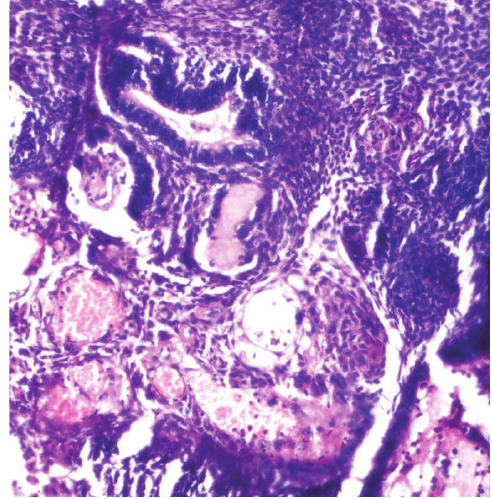
Figure 7: Odontogenic island in the stroma showing ghost cells.